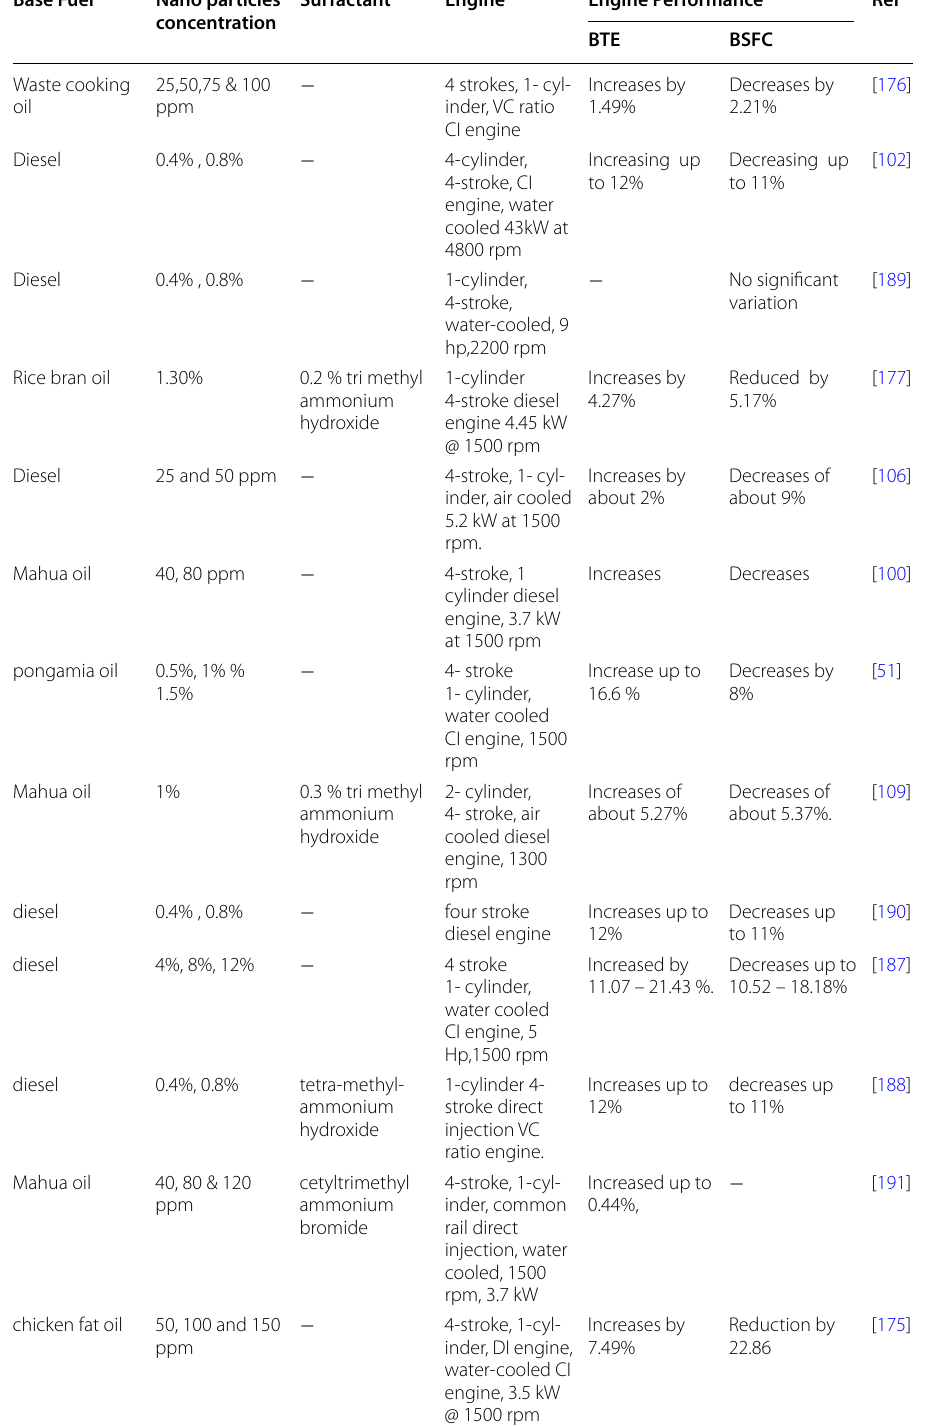
Table 5 Summary of magnetite nanoparticles on engine performance with various concentrations Base